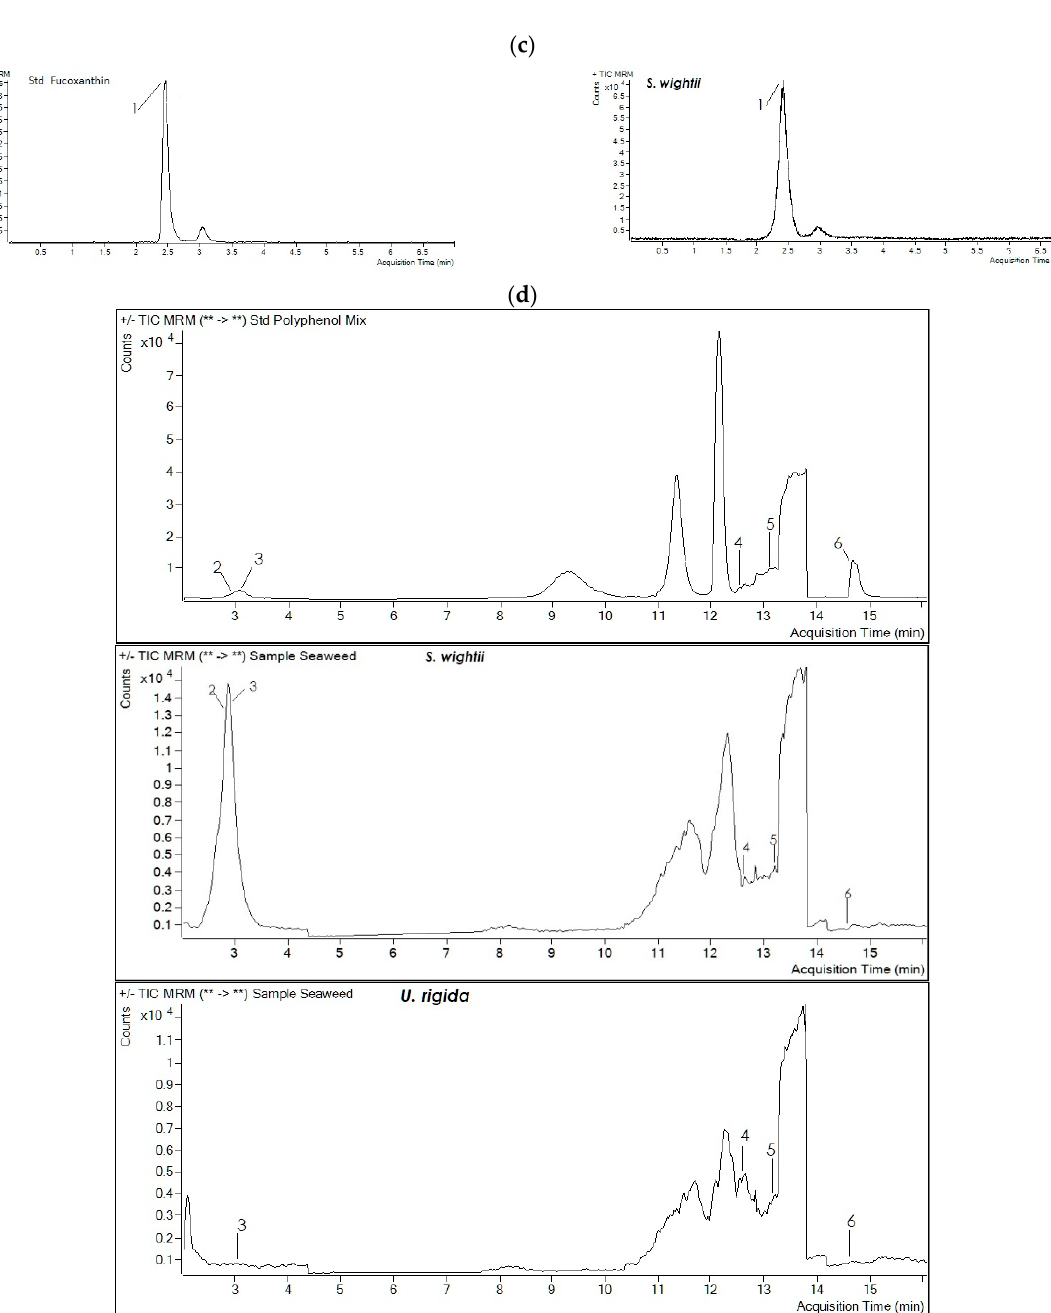
Figure 5. ( a ) LC-MS/MS total ion chromatogram (TIC) spectrum of standard and extracted compounds with retention time of peak. ( b ) ESI-MS spectrum of standard and extracted compounds with product and precursor ions. (A1) Fucoxanthin standard. (B1) Phloroglucinol standard. (C1) Gallic acid standard. (D1) Quercetin standard. (E1) Ferulic acid standard. (F1) Vanillin standard. Extracted compounds are (A2) fucoxanthin, (B2) phloroglucinol, (C2,C3) gallic acid, (D2,D3) quercetin, (E2,E3) ferulic acid, and (F2,F3) vanillin. SW = Sargassum wightii , UR = Ulva rigida; LC-MS/MS = liquid chromatography with tandem mass spectrometry; TIC = total ion chromatogram; ESI-MS = electron spray ionization–mass spectrometry. ( c ) LC-MS/MS total ion chromatogram (TIC) spectrum of standard (fucoxanthin) and extracted compounds from S. wightii . ( d ) LC-MS/MS total ion chromatogram (TIC) spectrum of standard and extracted compunds from S. wightii and U. rigida . * Acronyms in Figure 5c,d: 1 = fucoxanthin; 2 = phloroglucinol; 3 = gallic acid; 4 = vanillin; 5 = ferulic acid; 6 = quercetin.